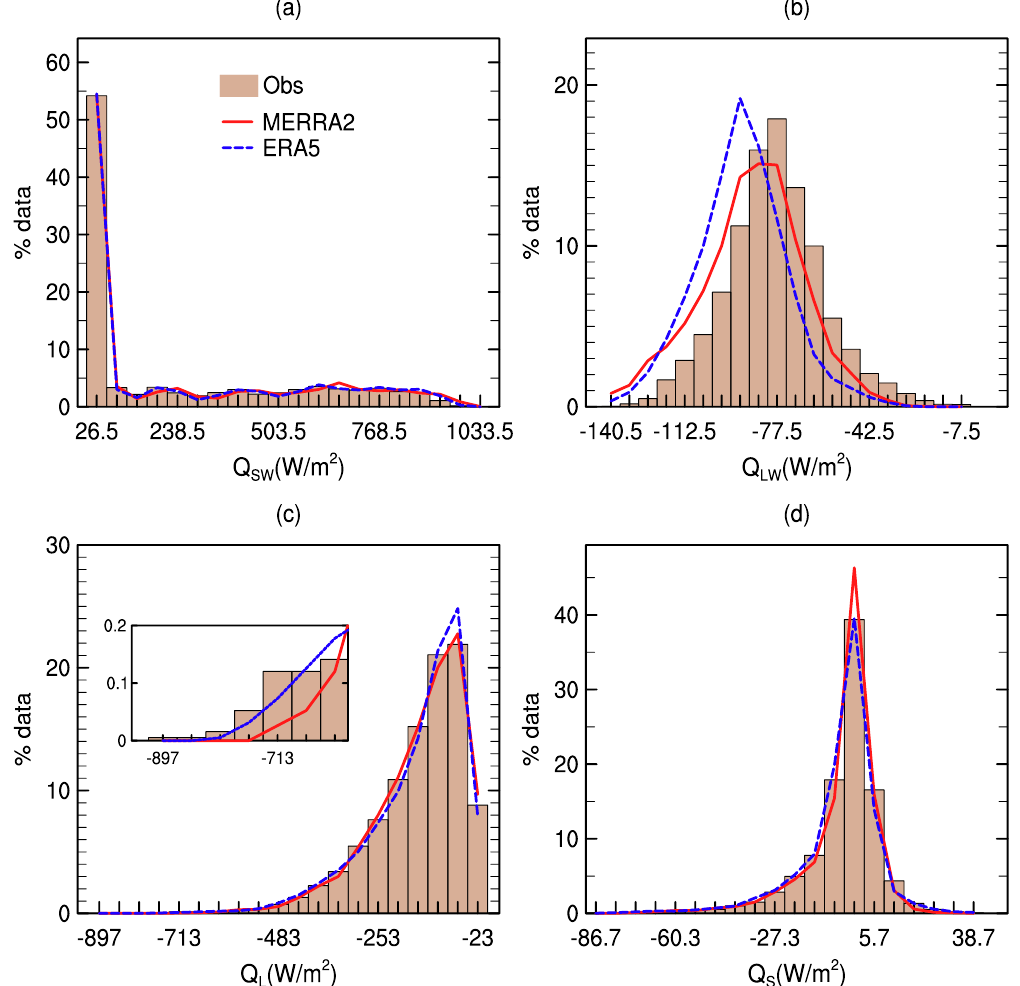
Figure 12. Surface air–sea fluxes histograms for the northern Red Sea derived from hourly-average in situ observations (bars) and reanalysis products (NASA-MERRA2 and ECMWF-ERA5, solid red and dashed blue lines, respectively): ( a ) net shortwave radiation ( Q sw ), ( b ) net longwave radiation ( Q LW ), ( c ) latent heat ( Q L ), and ( d ) sensible heat ( Q S ). Histograms were computed using twenty bins, evenly spaced between the minimum and maximum values. Vertical axes indicate the percentage of 19,119 collocated tuples (in situ, MERRA2, ERA5) that fall in the respective bins. Negative values indicate sea heat loss. The inset (c) shows the tail of the Q L